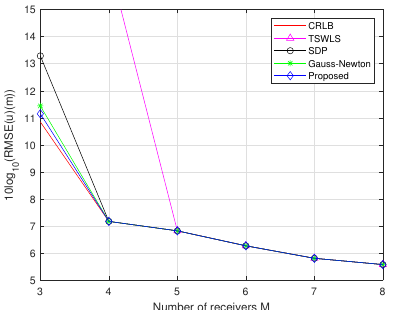
Figure 6. RMSE comparison for estimating target position at σ 2 = 10 m 2 and σ 2 s = 1 m 2 .